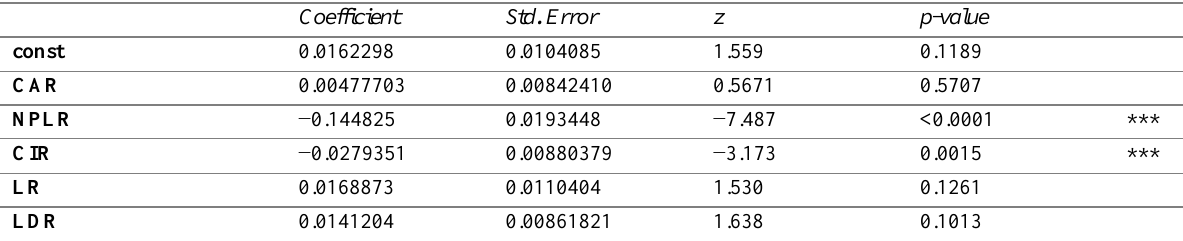
Table 6: Random-Effects Model: ROA is the dependent variable